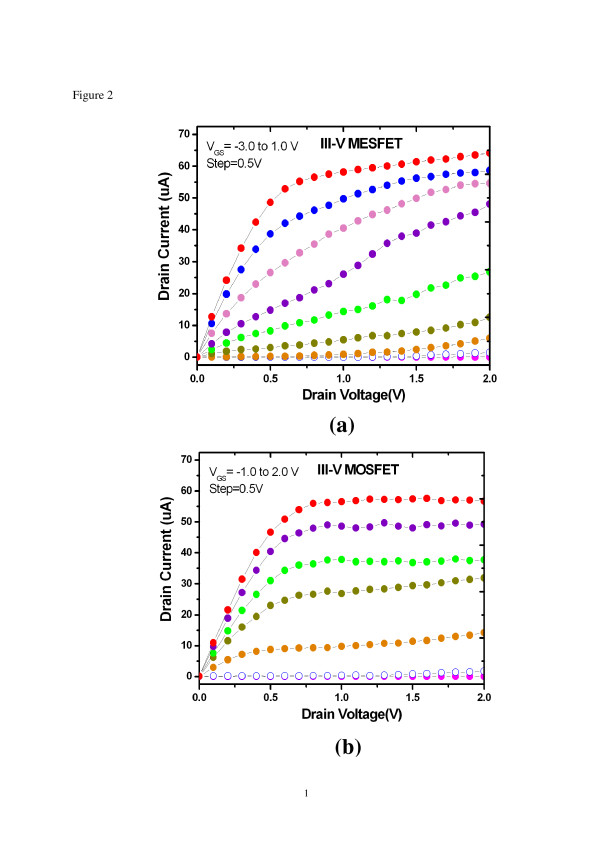
I DS -V DScharacteristics with FinFET structure. (a) 0.5-μm III-V MESFET and (b) 0.5-μm III-V MOSFET.